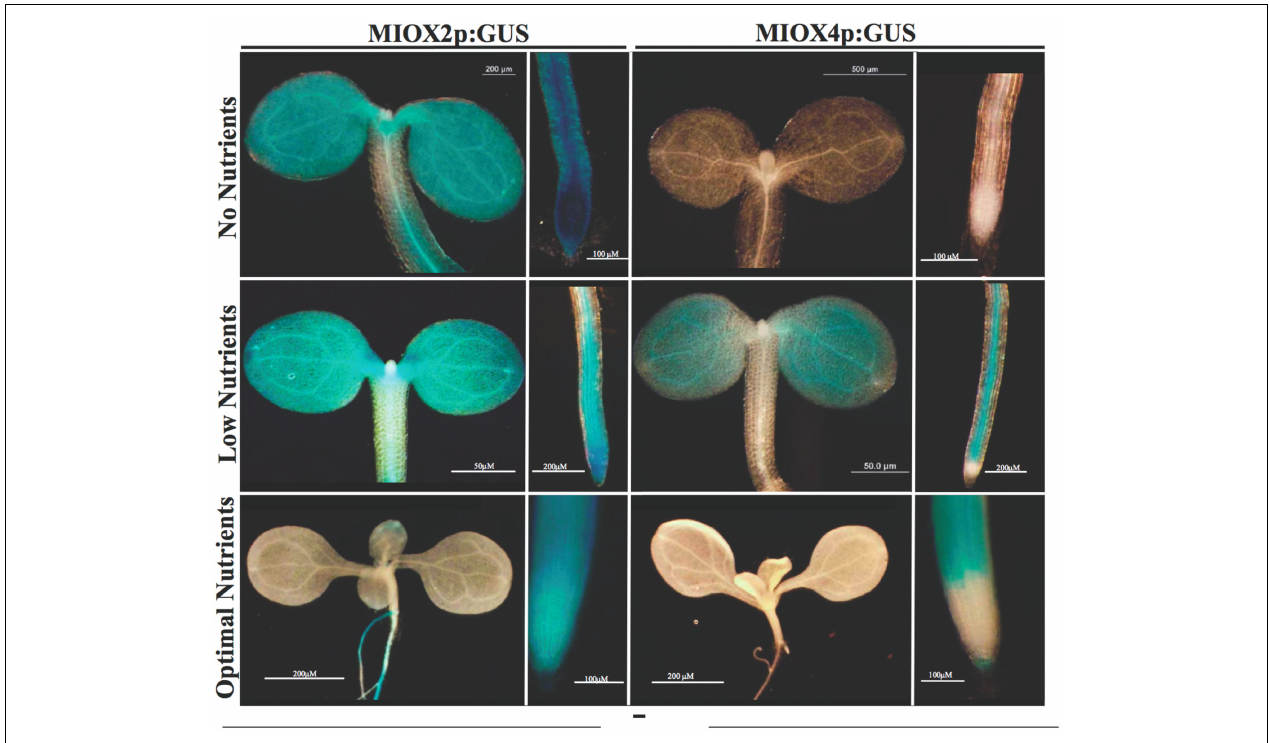
FIGURE 1 | MIOX2 and MIOX4 expression varies with nutrient conditions. WT, MIOX2p:GUS, and MIOX4p:GUS 5- to 7-day seedlings were grown on no nutrient (upper), low nutrient (lower), or optimal nutrient